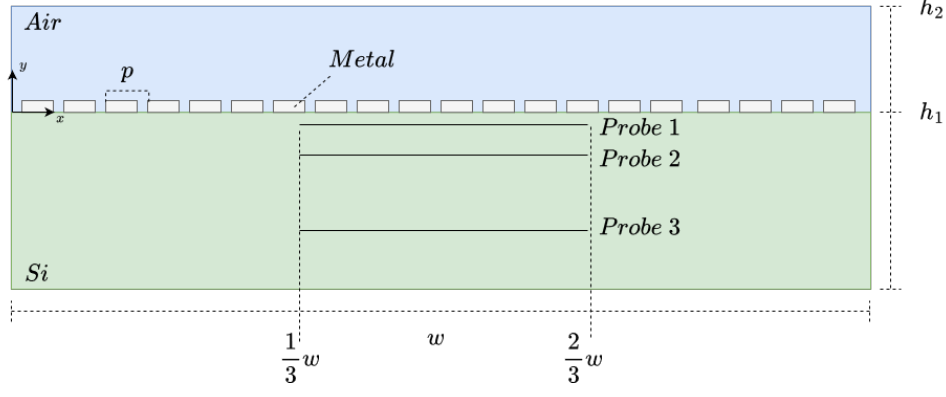
Figure 1. Illustrative representation of the